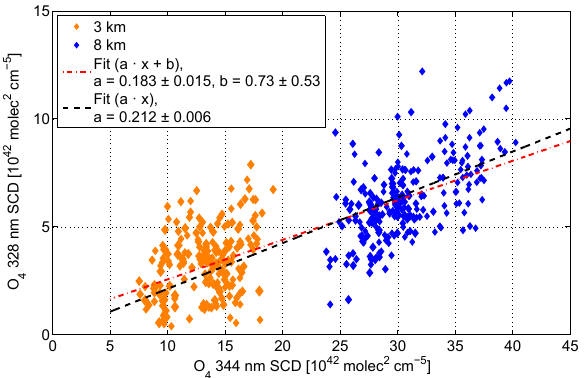
Figure 3. LP-DOAS correlation of the suspected 328nm absorption feature with the known absorption at 343.8nm. Data for the short light path are shown in orange and for the long path in blue. Linear regression results are shown with and without for a constant offset